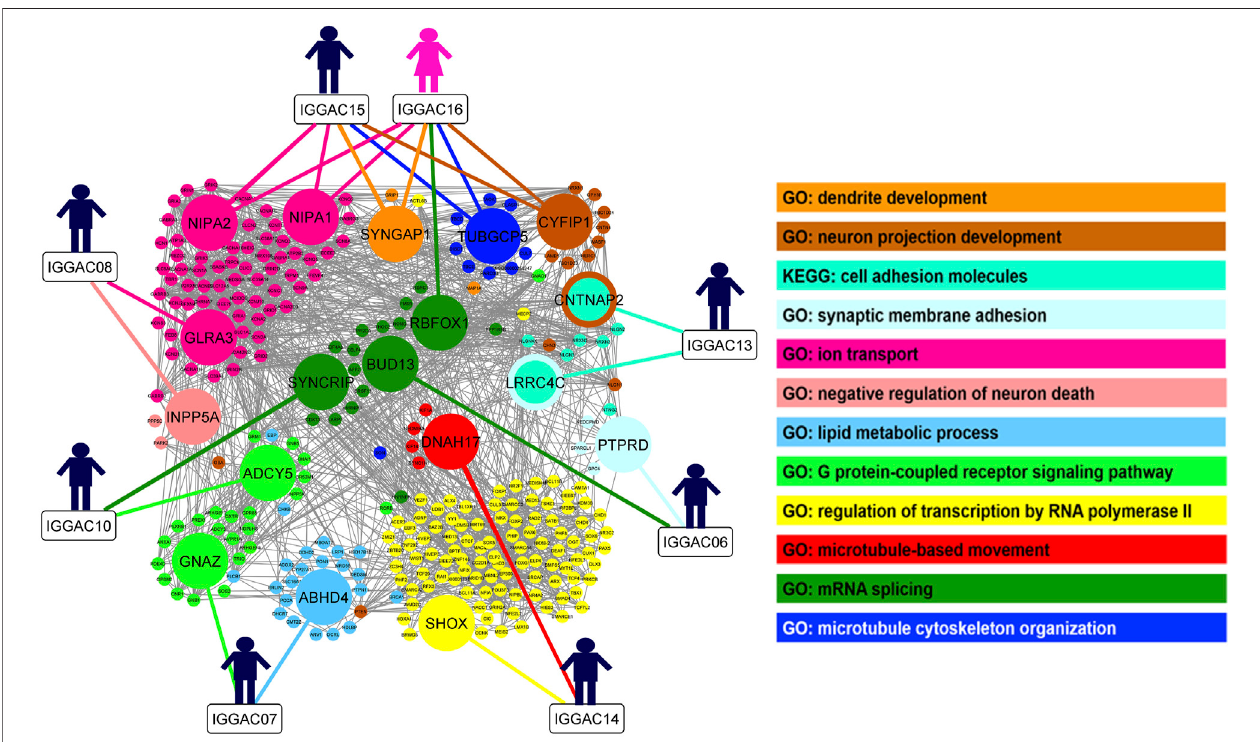
FIGURE 10 | Overview of biological processes and pathways involved in patients with CNV-genes acting according to double-hit model. The network depicts the protein-protein interactions (grey lines) revealed by STRING analysis (visualized by Cytoscape tool) on the basis of the enrichment obtained with GeneCodis4 tool. The Figureshows the enriched BP terms and KEGG pathways clustering the CNV-genes ofthe eight patients with known NDD genes (SFARI reported genes with score1/2 and OMIM genes correlated to NDDs). The analysis shows that all eight patients have CNV-overlapped genes involved in two known NDD-associated biological processes, except patient IGGAC13, for whom the two implicated genes appeared in the same KEGG pathway. GO terms “ neuron projection development ” , “ synaptic membrane adhesion ” , “ ion trasport ” , “ G-protein-coupled receptor signalling pathway ” and “ mRNA splicing ” are shared by at least two different patients.